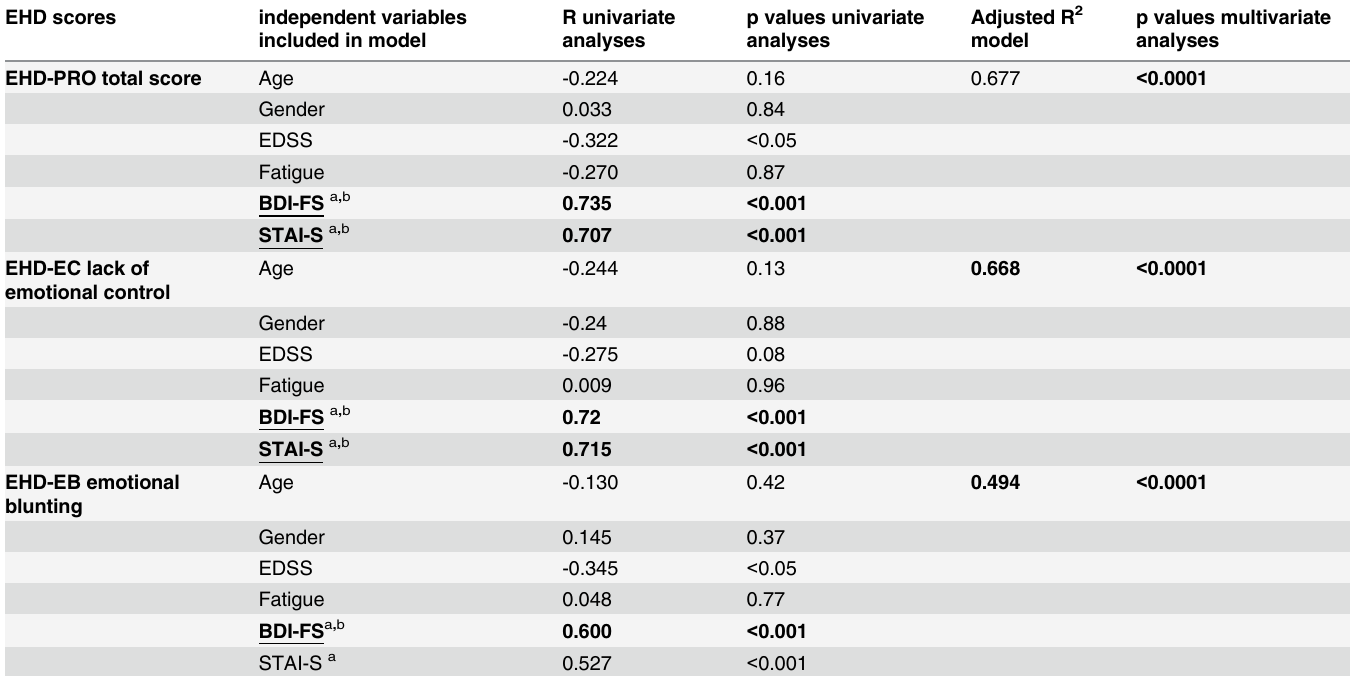
Table 3. Linear regression models describing EHD scores in